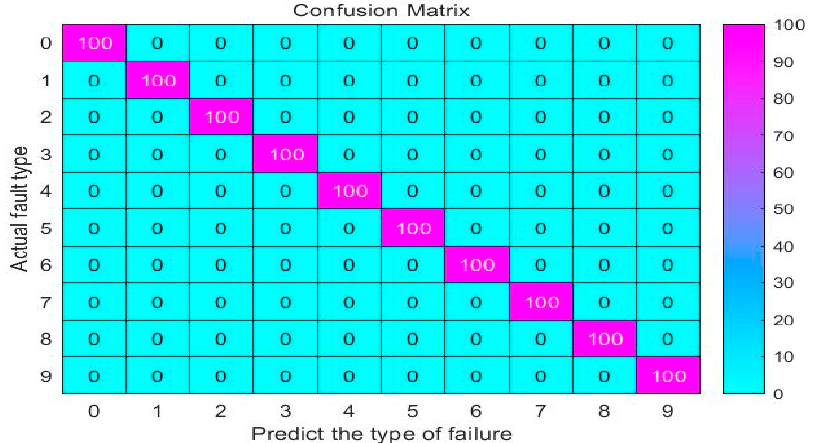
Figure 19. The confusion matrix of 1DCNN.